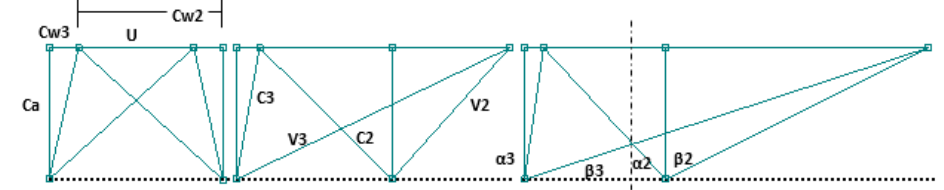
Figure 16. Preliminary design velocity triangles at root ( left ) mean ( centre ) and tip ( right ).